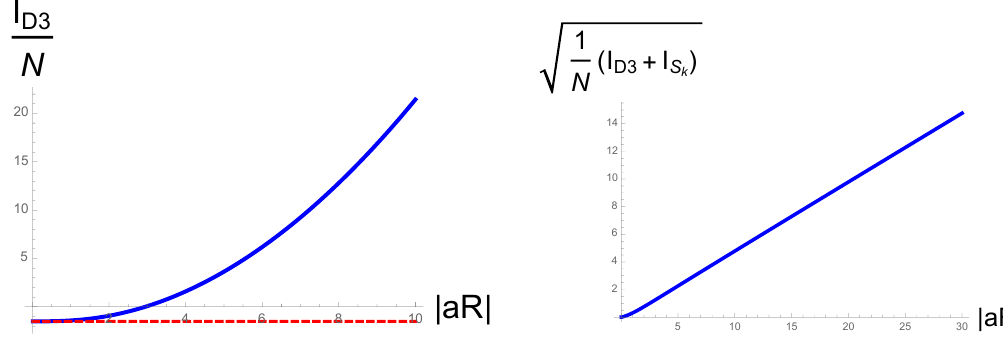
Figure 6 . The free energy (cid:0) ln Z H = I D3 (2 (cid:25) ) of the D3-brane solution with a < 0 in hyperbolic space with (cid:12) = 2 (cid:25) and ~ (cid:20) = 0 : 7. For small deformations (UV), it matches the symmetric